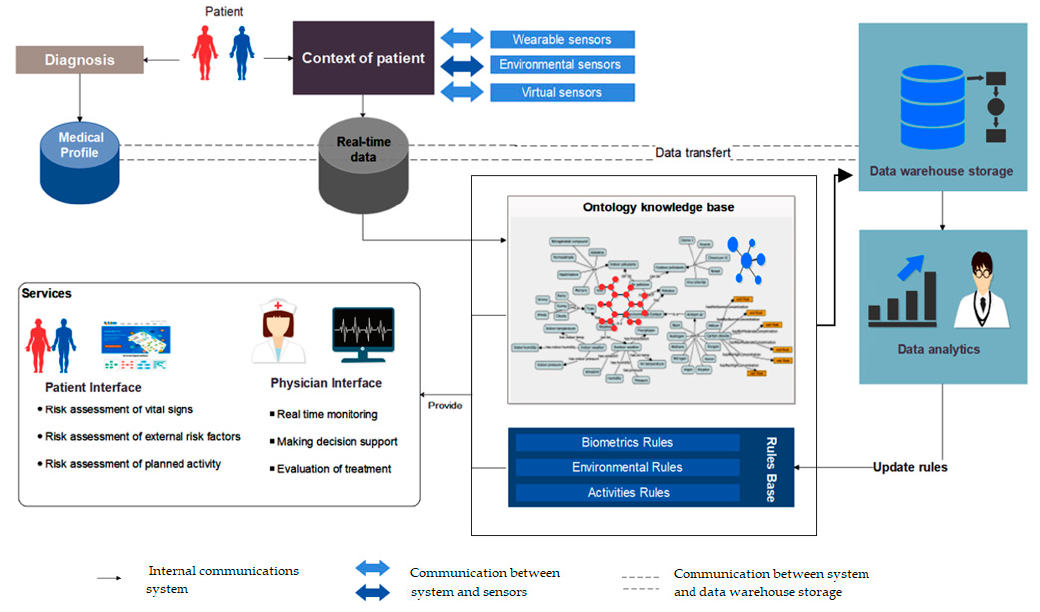
Figure 1. General architecture .